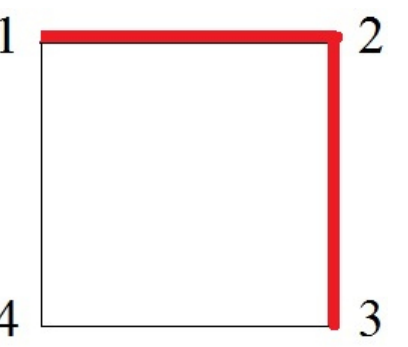
Figure 9. C 4 : by “rotating” the packing set, one can see that each vertex is not included in some packing, so x 1 = . . . = x 4 = 0, , which contradicts condition x 1 + . . . + x 4 =